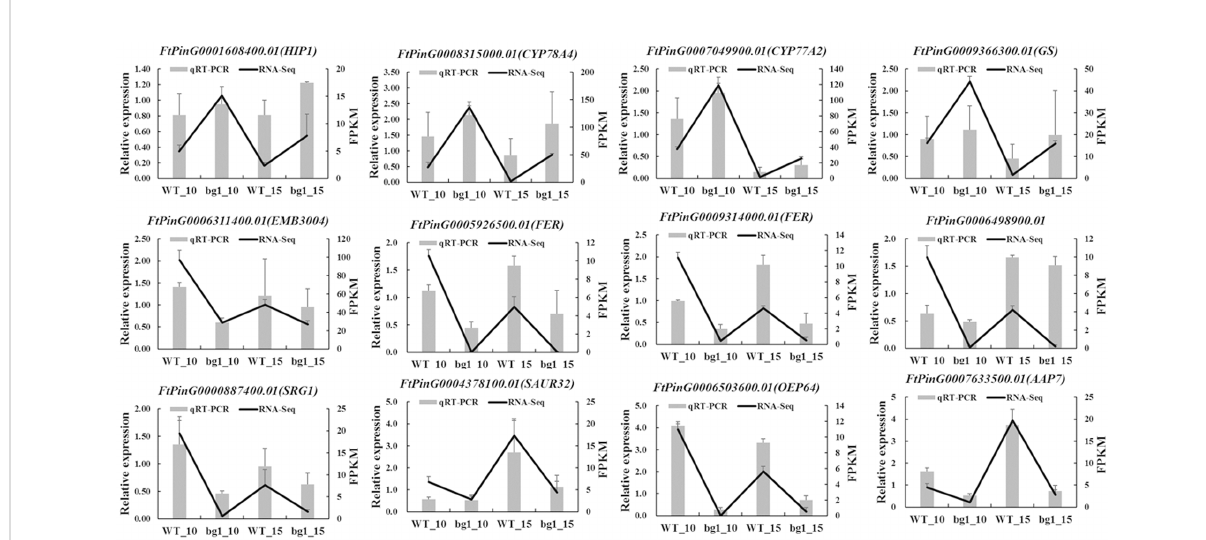
FIGURE 8 qRT-PCR validation of 12 differentially expressed genes related to grain size. The column diagram represents the relative expression determined with qRT-PCR and the line chart represents the level of expression (FPKM) determined with RNA-seq. Error bars indicate the standard errors from three independent biological and three technical replicates for qRT-PCR